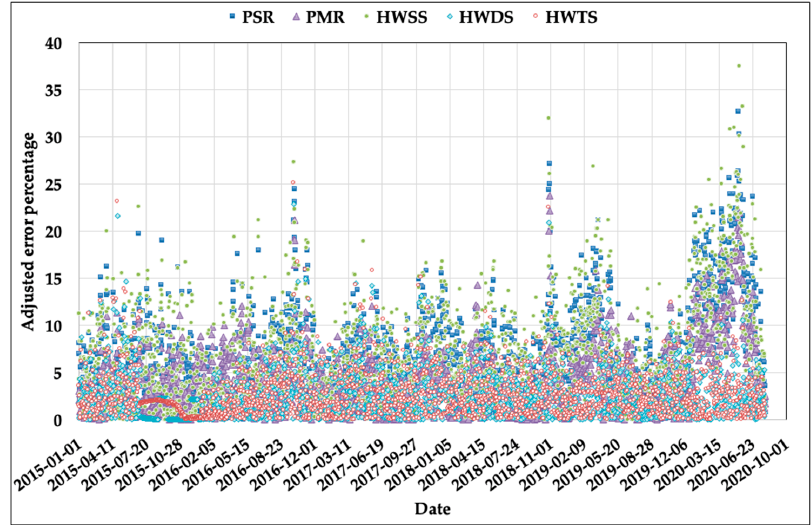
Figure 4. Relative errors percentage for the five models.